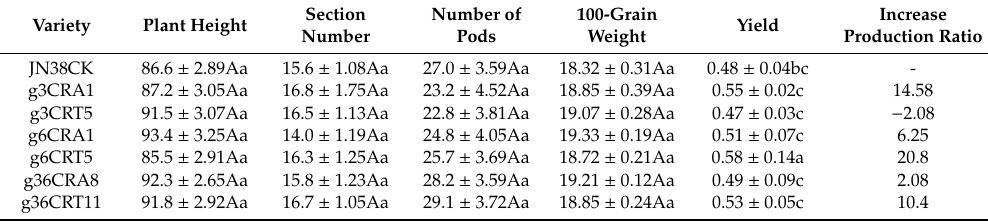
Table 4. Investigation on Agronomic Characters of Transgenic